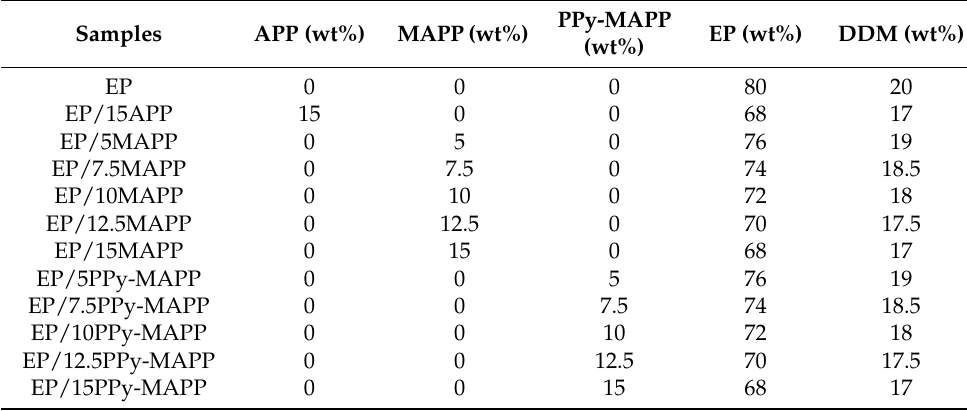
Figure 1. Preparation process of PPy-MAPP and EP composites. Table 1. Formulations and flammability of pure EP and EP composites.